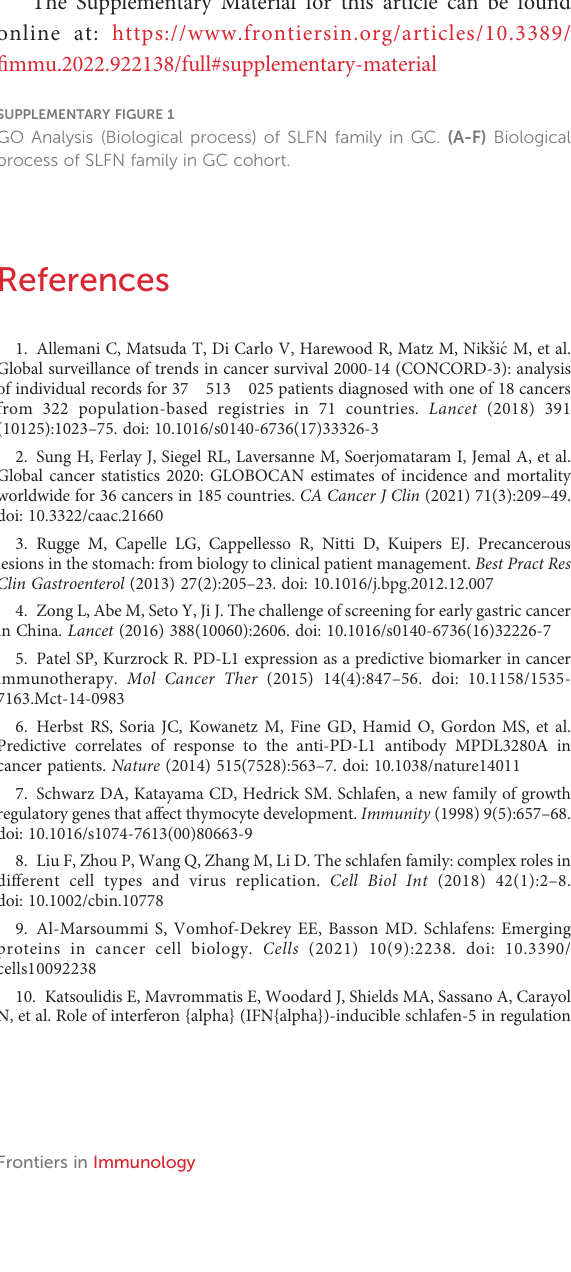
SUPPLEMENTARY FIGURE 2 Tumor immune cell in fi ltration associated to SLFN. (A-F) The relationship between theexpression of SLFNfamily membersandtumor immune cells in gastric cancer was analyzed using Timer database with purity- corrected partial Spearman correlation test. (A-D, F) The expression of SLFN5, SLFN11, SLFN12, and SLFN12L in gastric cancer was signi fi cantly positively correlated with the in fi ltration of CD8 + T cells, CD4 + T cells, macrophages, neutrophils,anddendriticcells,butnotwiththeabsenceof in fi ltration of B cells. (E) SLFN13 expression in gastric cancer has no signi fi cant relationship with immune cell in fi ltration. (F) SLFN14 is positively correlated with all in fi ltration immune cells. SUPPLEMENTARY FIGURE 3 Tumor immune cell in fi ltration associated to SLFN. Tumor immune cell in fi ltration associated to SLFN in CRC investigated by TISIDB database. (A- C) The expression of SLFN5, SLFN11, and SLFN12 was positively correlated with NK cells, Th17 cells and Treg cells in gastric cancer. SUPPLEMENTARY FIGURE 4 RelationshipbetweenSLFNfamilymembersandimmunecheckpoints.TISIDB databasewasusedtoanalyzethecorrelationbetweenSLFN5,SLFN11,SLFN12, and SLFN13, and CD160, CD244, CD247, CTLA4, LAG3, PDCD1, PDCD1LG2, TIGIT, and HAVCR2. (A-D) SLFN5, SLFN11, and SLFN12 were positively correlated with CD160, CD244, CD247, CTLA4, LAG3, PDCD1, PDCD1LG2, TIGIT, and HAVCR2 in gastric cancer. (D) SLFN13 expression in gastric cancer has nosigni fi cant correlationwith immunecheckpoint. SUPPLEMENTARY FIGURE 5 Relationship betweenSLFNfamilymembersandimmunecheckpoints. (A) SLFN12LwerepositivelylinkedwithCD160,CD244,CD247,CTLA4,LAG3, PDCD1, PDCD1LG2, TIGIT, and HAVCR2. (B) SLFN14 expression was positively correlated with CD160, CD244, CD247, PDCD1, PDCD1LG2, and TIGIT, but not with CTLA4, LAG3, and